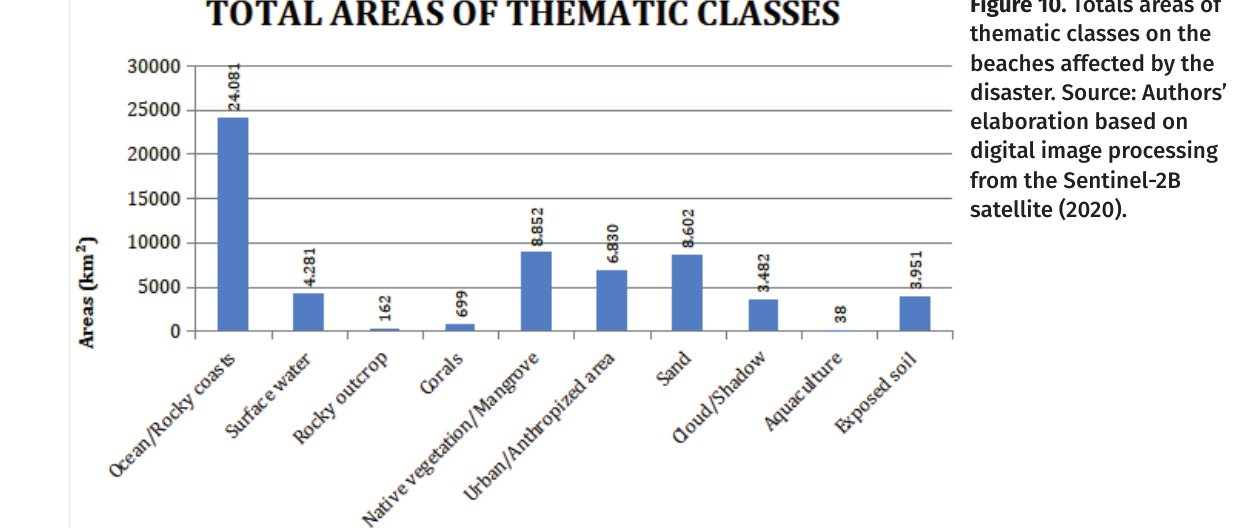
Figure 10. Totals areas of thematic classes on the beaches affected by the disaster. Source: Authors’ elaboration based on digital image processing from the Sentinel-2B satellite